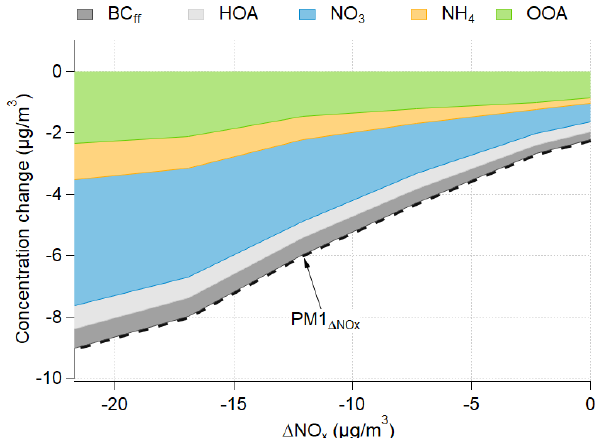
Figure 10. Impact of regional NO x concentration change on PM- related species (BC ff , HOA, NO 3 , NH 4 , OOA). (cid:49) NH 4 was esti- mated from (cid:49) NO 3 , assuming aerosol neutralization (Petit et al.,